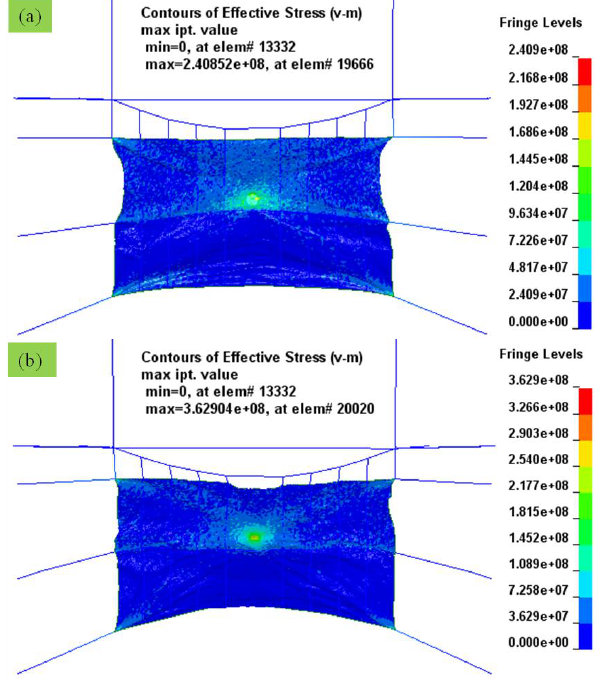
Fig. 21. Numerically simulated von-Mises stress distribution in the R-LPR structure integrated with the Dhakal-LPR Brake Model devices subject to rockfall impact energies of 150kJ (a) and 400kJ (b) hit by the idealized cylindrical block equivalent to that used in the past full-scale